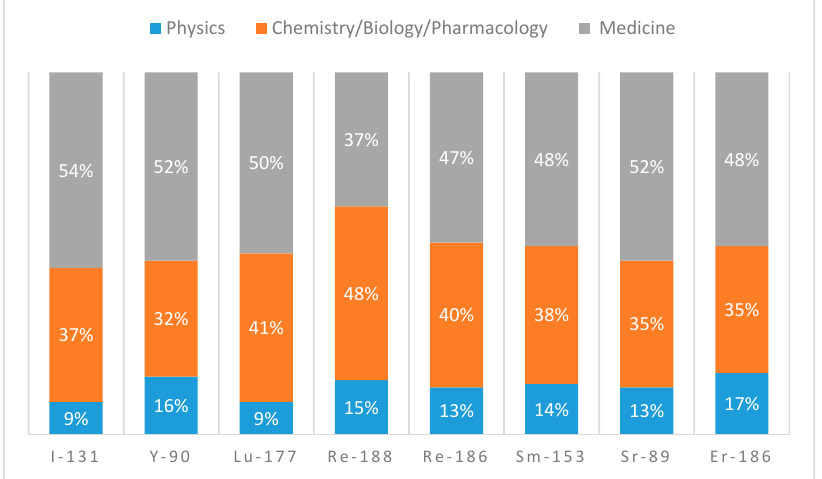
Figure 4 . CRN macro-areas contribution (2008–2018).